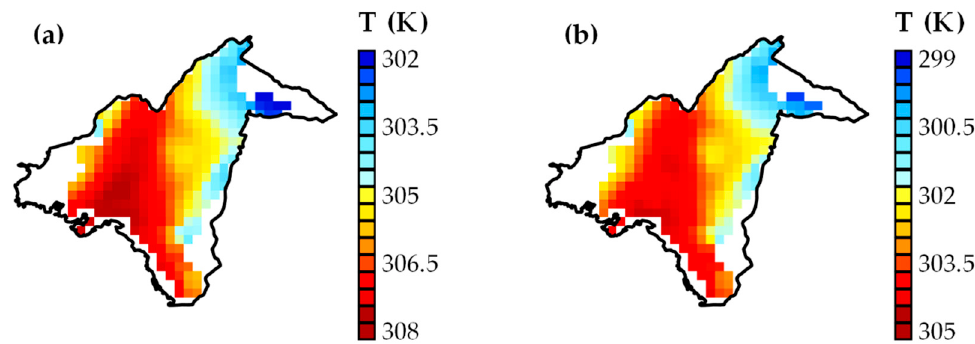
Figure 16. Spatial distribution of the modeled near-surface temperature in Athens using WRF (diagnostic variable T as ) (7–11 August 2017), during daytime ( a ) and during nighttime ( b ).